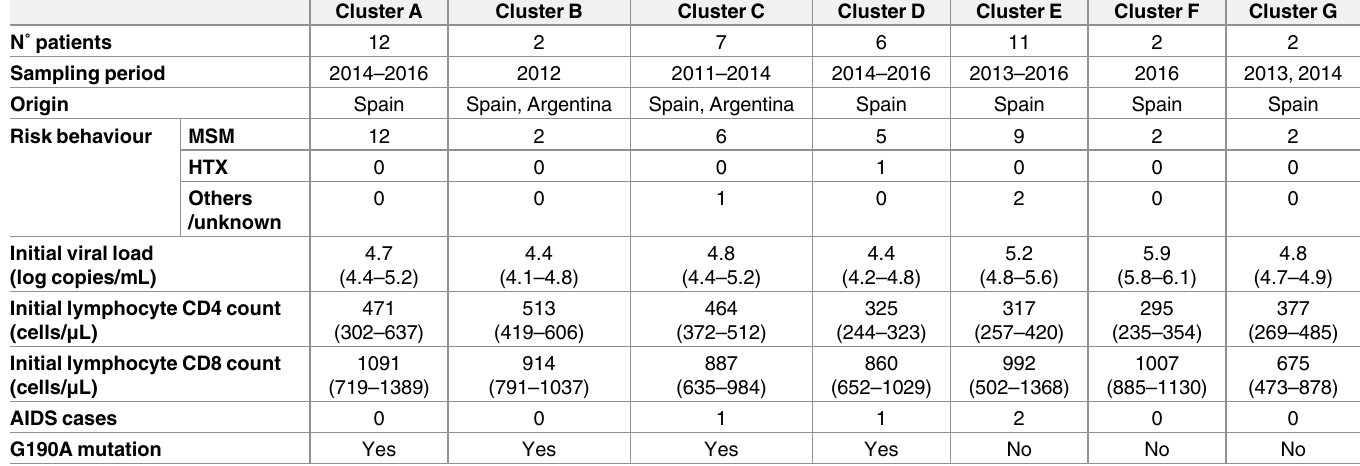
Table 1. Summaryof the main demographic, clinical and virological data for the seven subclusters found (pp (cid:21) 0.9), named according to appear- ance in the phylogeny inferred by Bayesiananalysis (Fig 2, S2